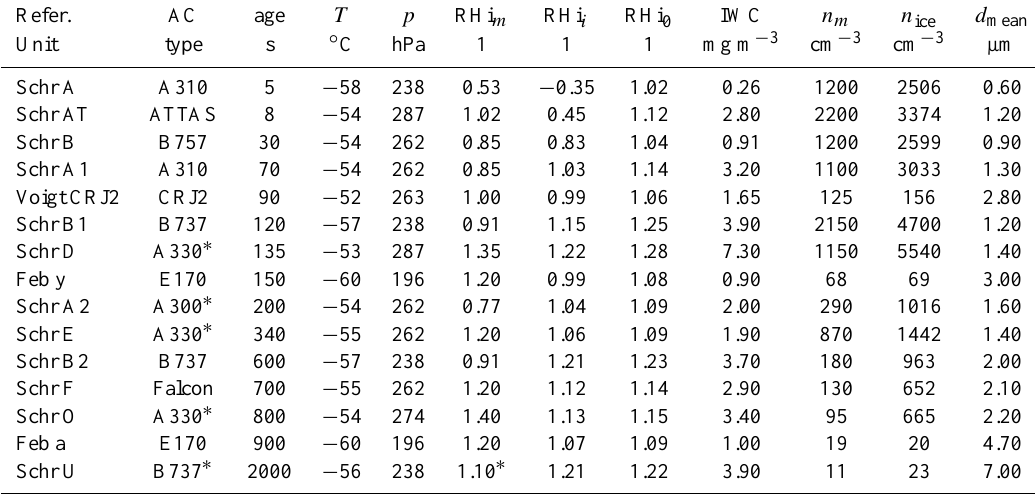
Table 4. Observed contrail properties for comparison with simulations. Refer.: Schr – Schr¨oder et al. (2000) with corresponding aircraft types indicated, Feb – Febvre et al. (2009) for young (y) and aged (a) contrails, and one case of Voigt et al. (2010). For explanation of negative RHi i , see text. Stars ∗ indicate estimated values.